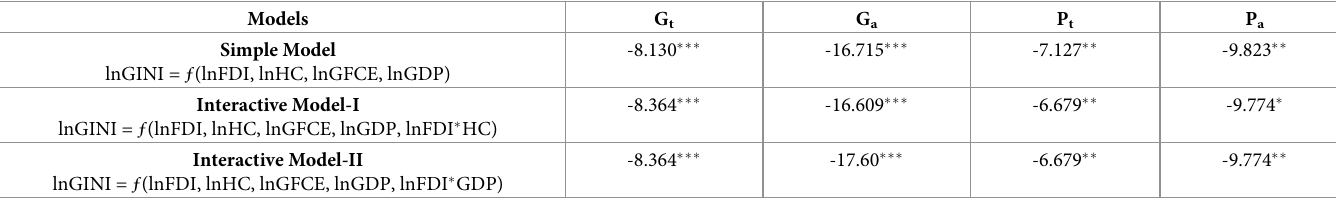
Table 4. Westerlund co-integration